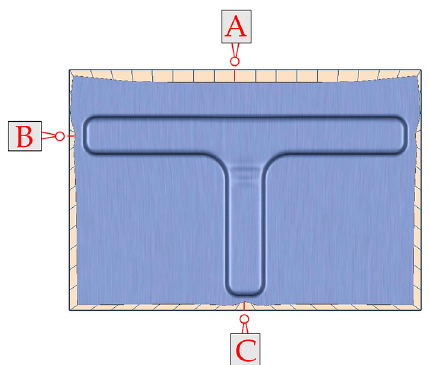
Figure 1. T-shaped component and points where the drw-in was monitored (A, B and C).